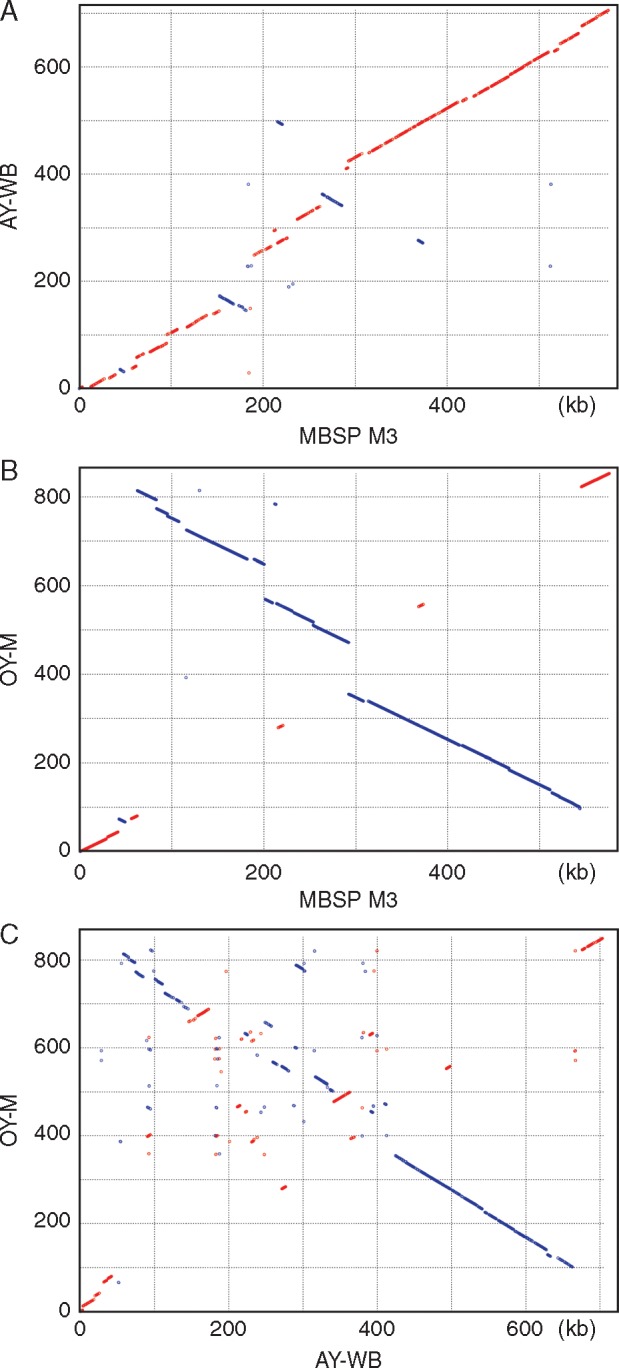
Pairwise genome alignments. Matches on the same strand are indicated by red dots, and matches on the opposite strands are indicated by blue dots.